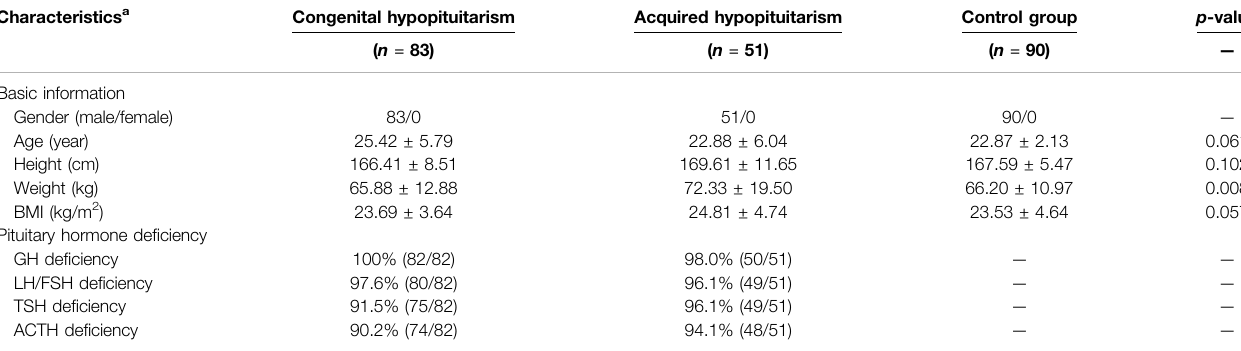
TABLE 1 | Clinical characteristics of the participants in identi fi cation study